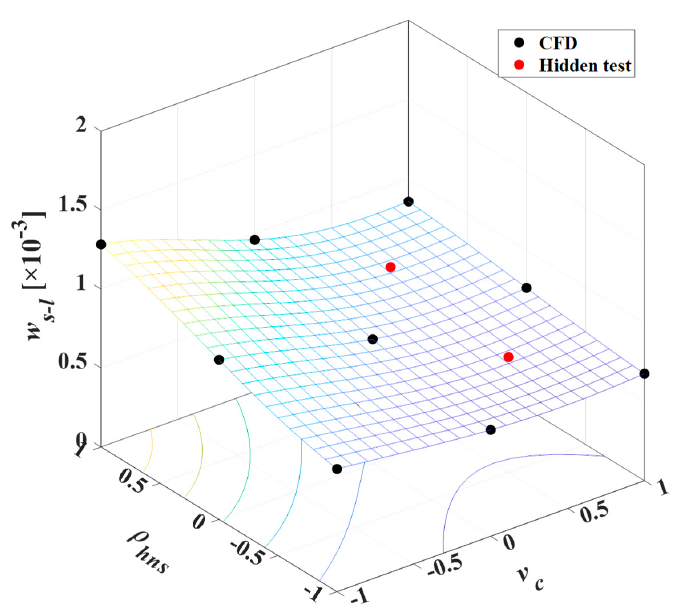
Appl. Sci. 2019 , 9 , 3838 13 of 15 Figure 8. Results of hidden point tests for eight di ff erent cases: w s − l for the side crack. Figure 8. Results of hidden point tests for eight different cases: 𝑤 (cid:3046)(cid:2879)(cid:3039) for the side crack.